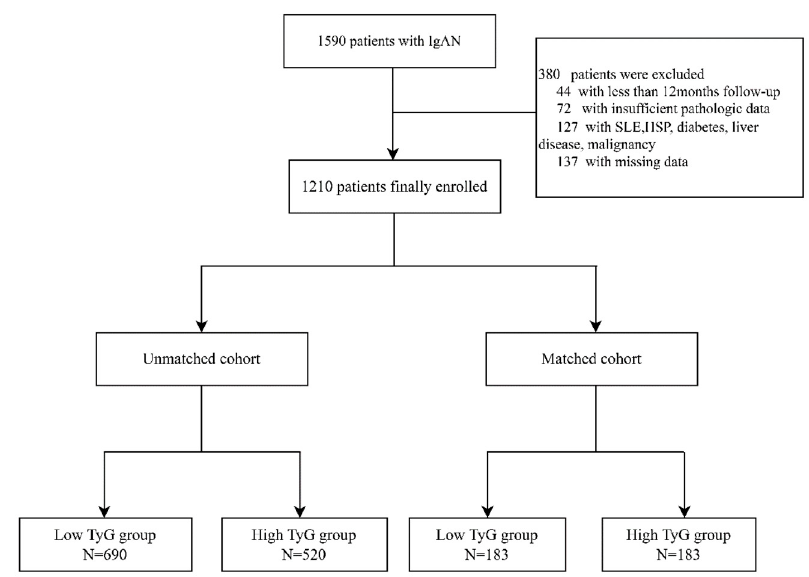
Figure 1. Study profile. Abbreviations: IgAN, IgA nephropathy; SLE, systemic lupus erythematosus; HSP, Henoch–Schönlein